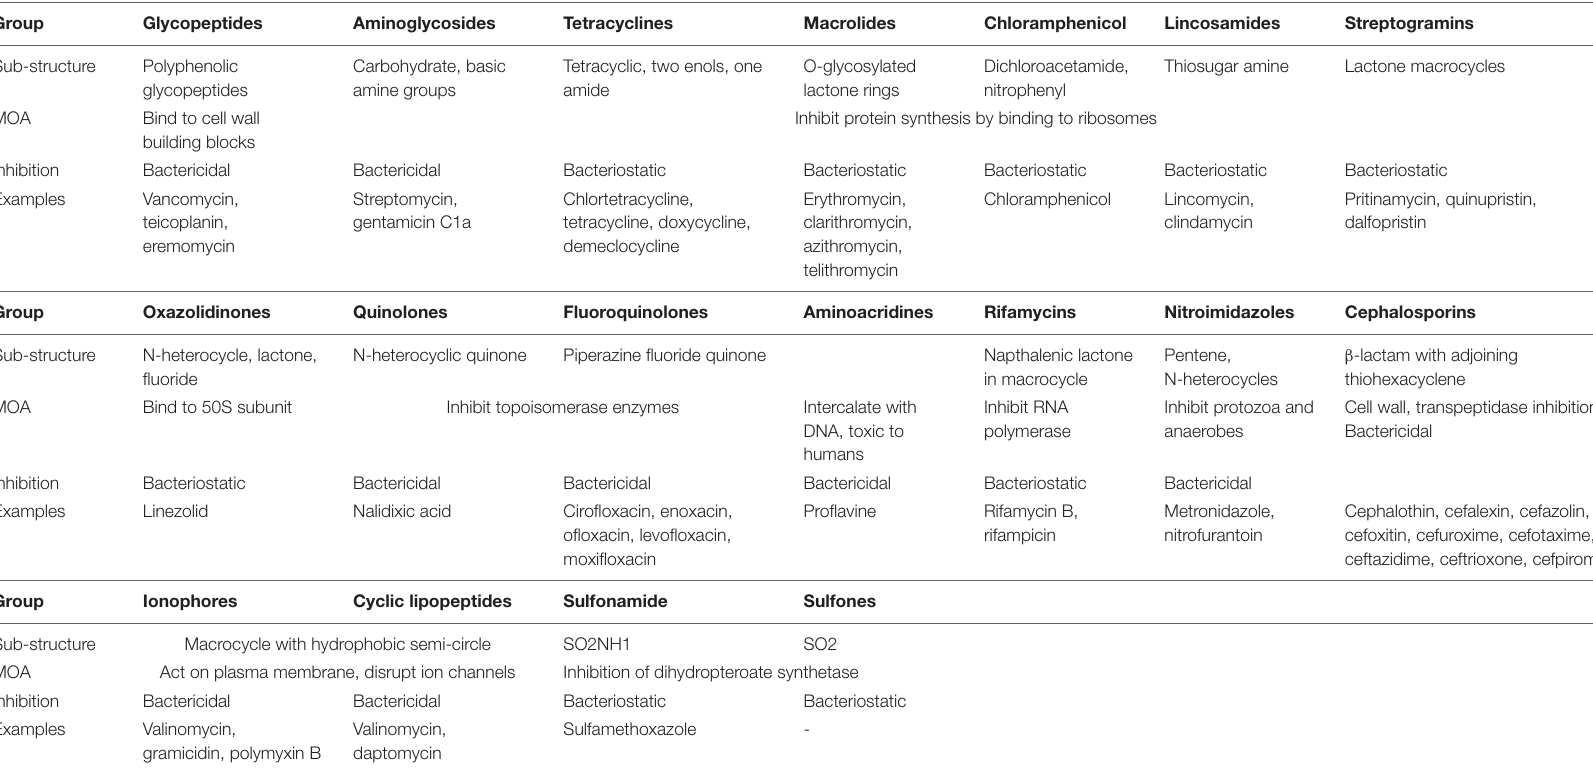
TABLE 2 | Other frontline antibiotics (Patrick,